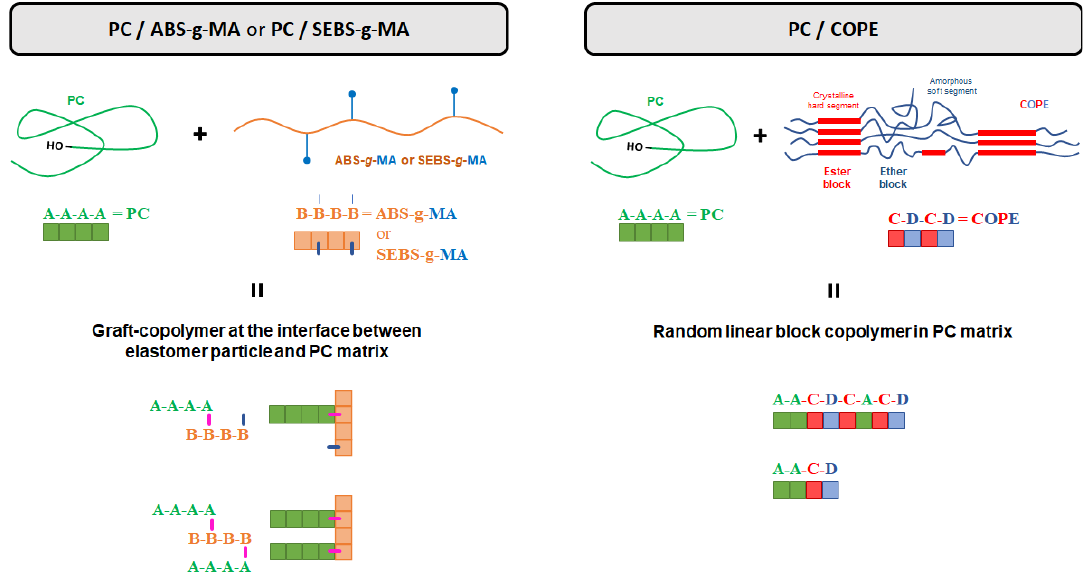
Figure 2. IR spectra of PC blended with 10 wt.% ABS, ABS- g -MA2, 1 wt.% SEBS- g -MA, and COPE, and their respective base materials.